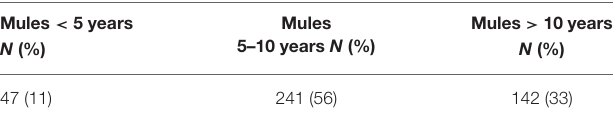
TABLE 3 | Age structure of working mules in Bahir Dar in 2010 (number (N) and %), from baseline data. Mules < 5 years